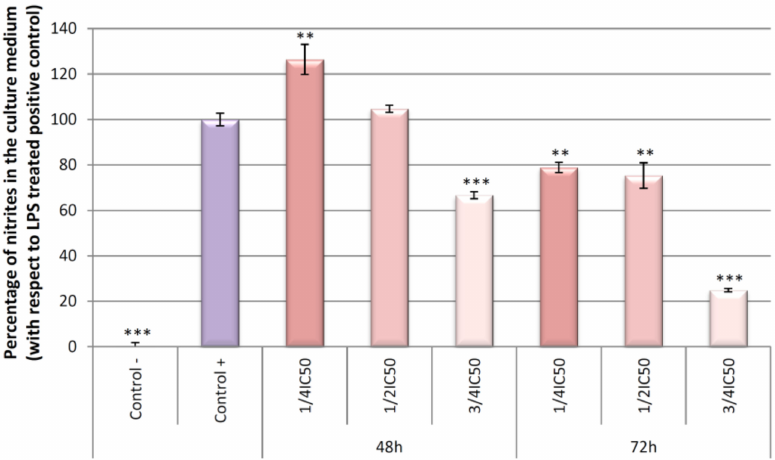
Figure 2. Effect of OADP on NO production in RAW 264.7 macrophage murine cells, after treatment with OADP for 48 h and 72 h at the 1 IC 50 and 3 IC 50 concentrations. Data represent the mean ± S.D. 2 4 of at least two independent experiments performed in triplicate. Key: (**) p < 0.01 and (***) p < 0.001, with respect to LPS-treated control cells (positive control).